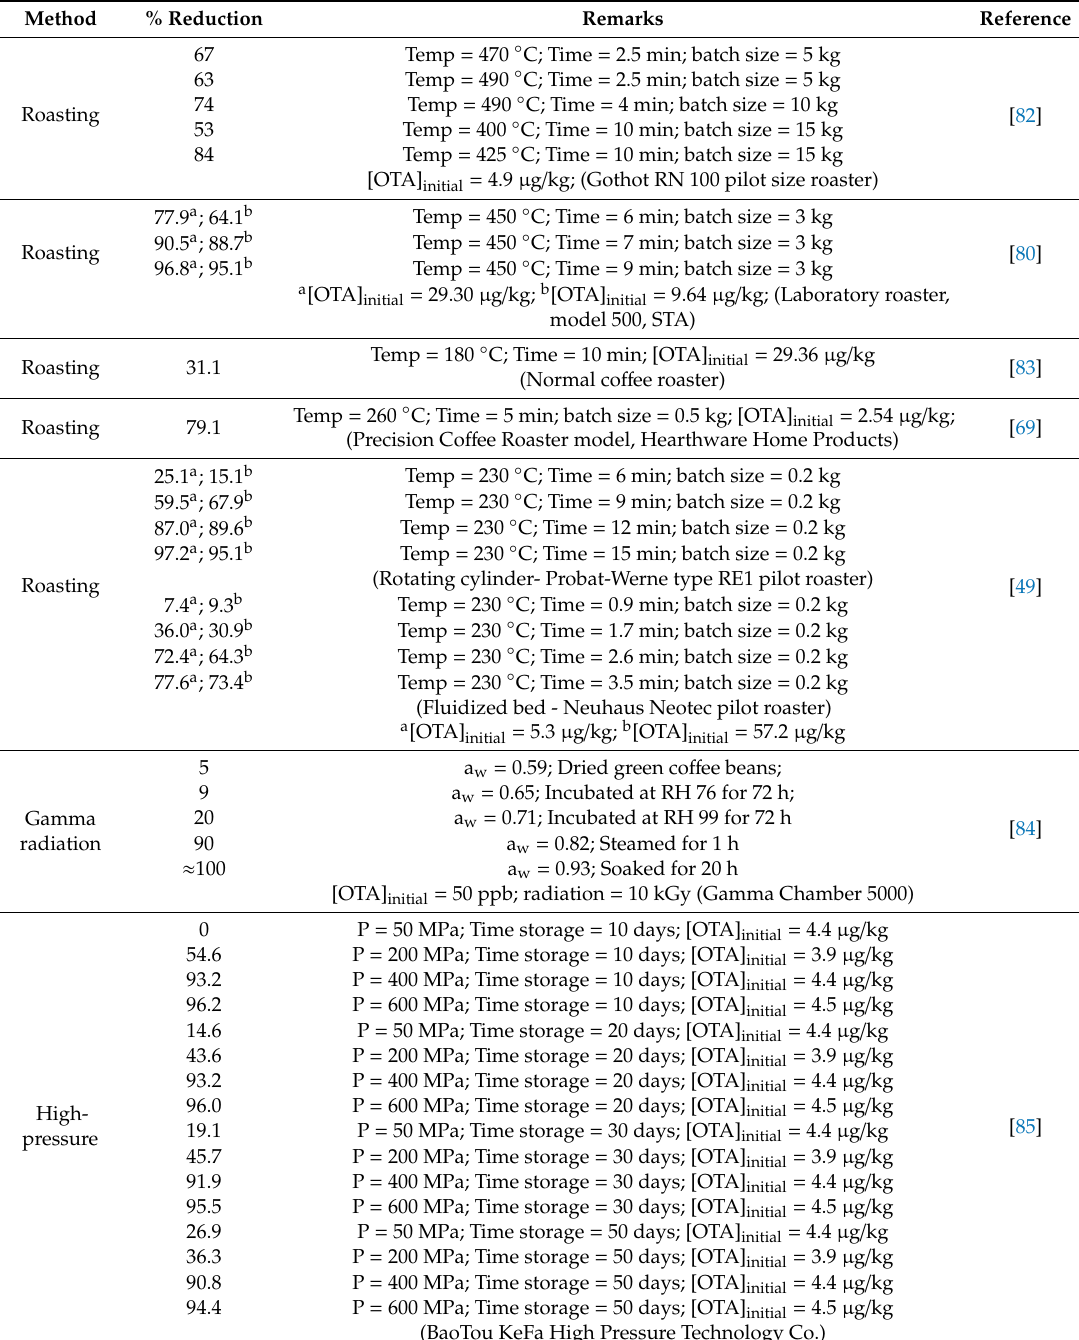
Table 3. Physical approaches for detoxification of